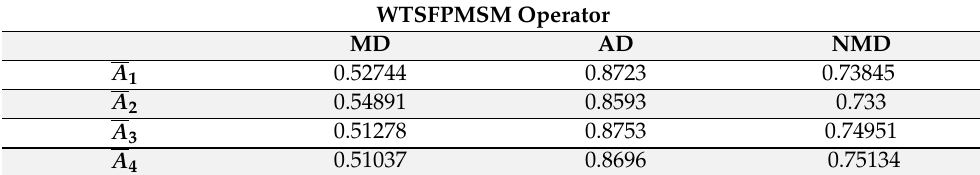
Table 17. T-spherical values by using data in Table 13 and the WTSFPMSM